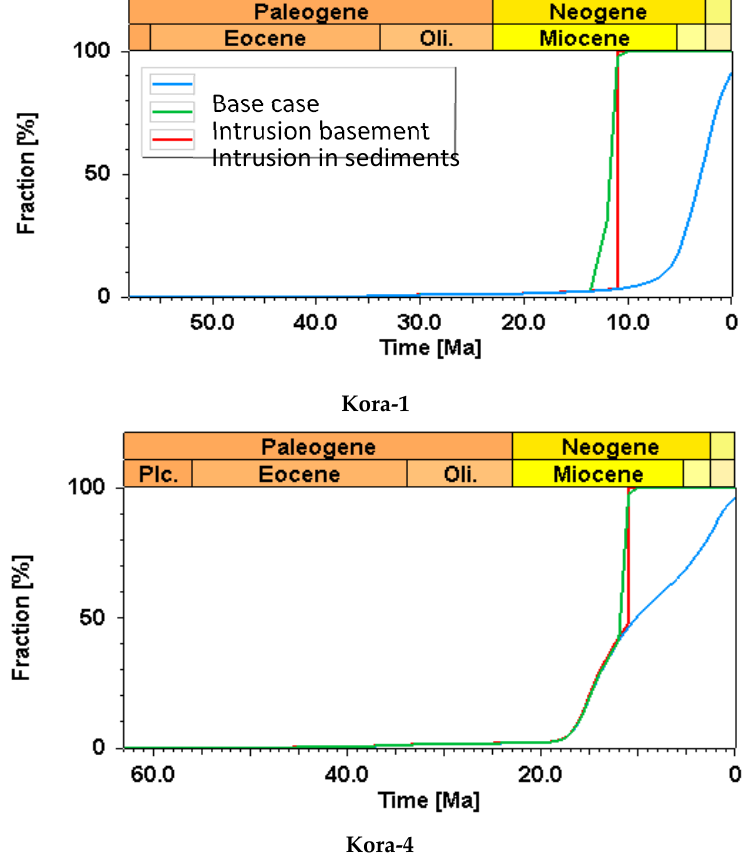
Figure 17. Transformation ratio plots for Kora-1 and Kora-4 illustrating three scenarios: magmatic intrusion, deep seated intrusion and base case scenario without intrusion.